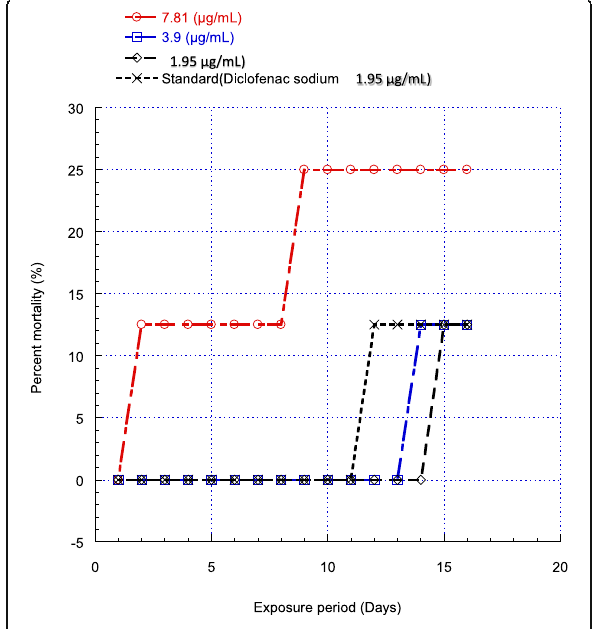
Fig. 2 Mortalities recorded during the sublethal test in tadpoles exposed to aqueous extract of Guibourtia tessmanii for 16 days